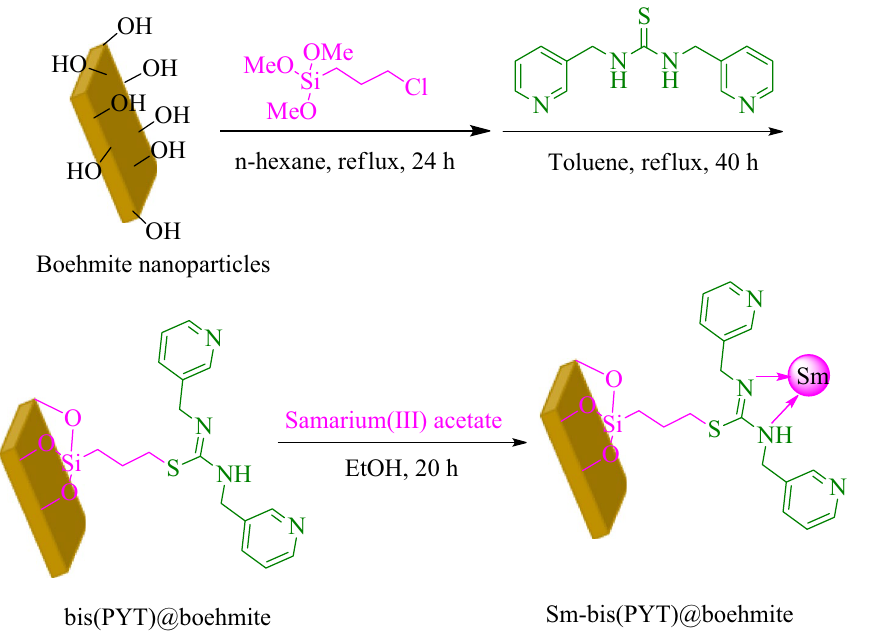
Figure 1. Synthesis of